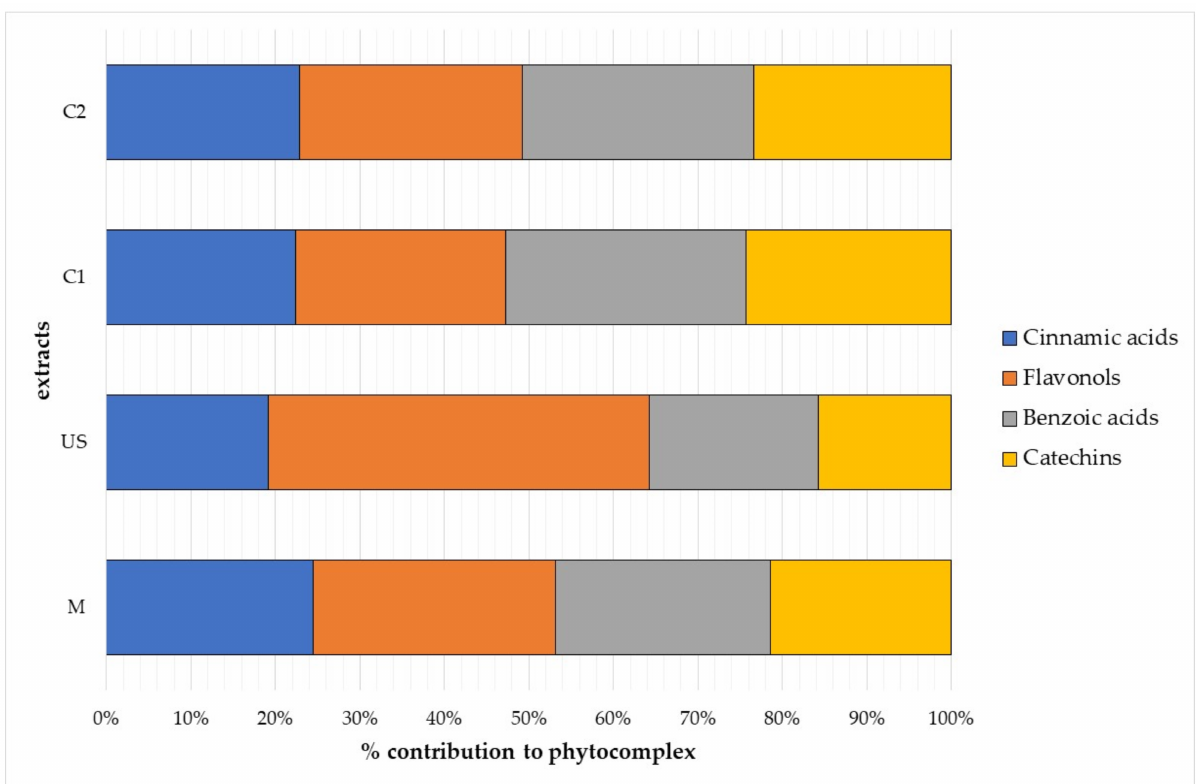
Figure 4. The phenolic composition of analysed V. vinifera bud-extracts. Mean values are shown ( n = 3); commercial bud-preparations, C1 and C2; traditional macerate, M; ultrasound extract,